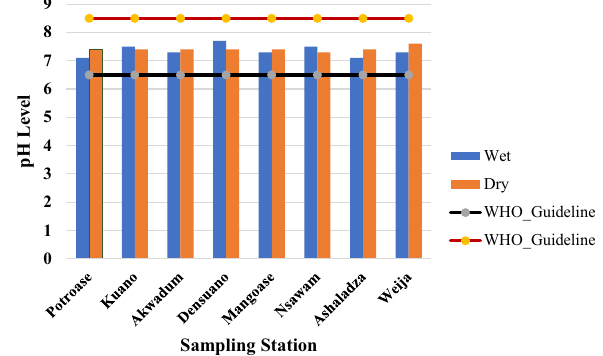
Fig. 2 Average pH for the sampling seasons